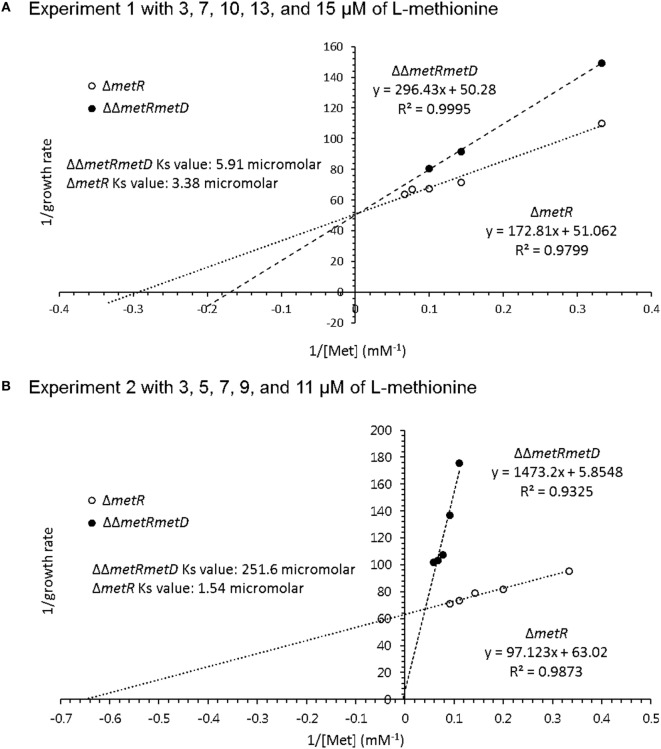
Whole-cell affinity comparing growth of ΔmetR and ΔΔmetRmetD mutant in minimal medium with added L-methionine. (A) Experiment 1 with 3, 7, 10, 13, and 15 μM of L-methionine; (B) Experiment 2 with 3, 5, 7, 9, and 11 μM of L-methionine.